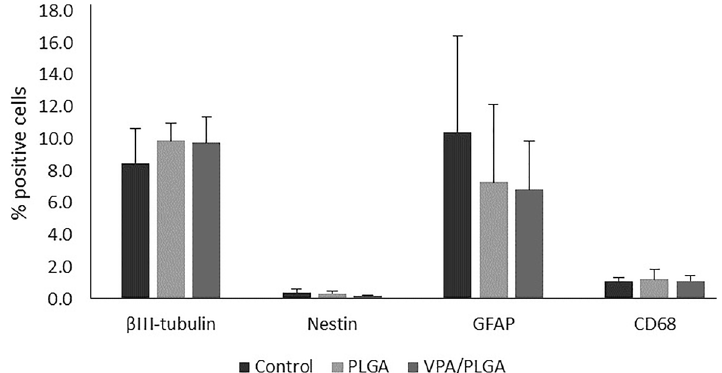
Figure 7. Analysis of expression of b III-tubulin, Nestin, GFAP, and CD68 by fl ow cytometry for the control, poly(lactic-co-glycolic acid) (PLGA), and valproic acid (VPA)/PLGA groups. Results are reported as percentage of positive cells (n=4/ group). Data are reported as means ±